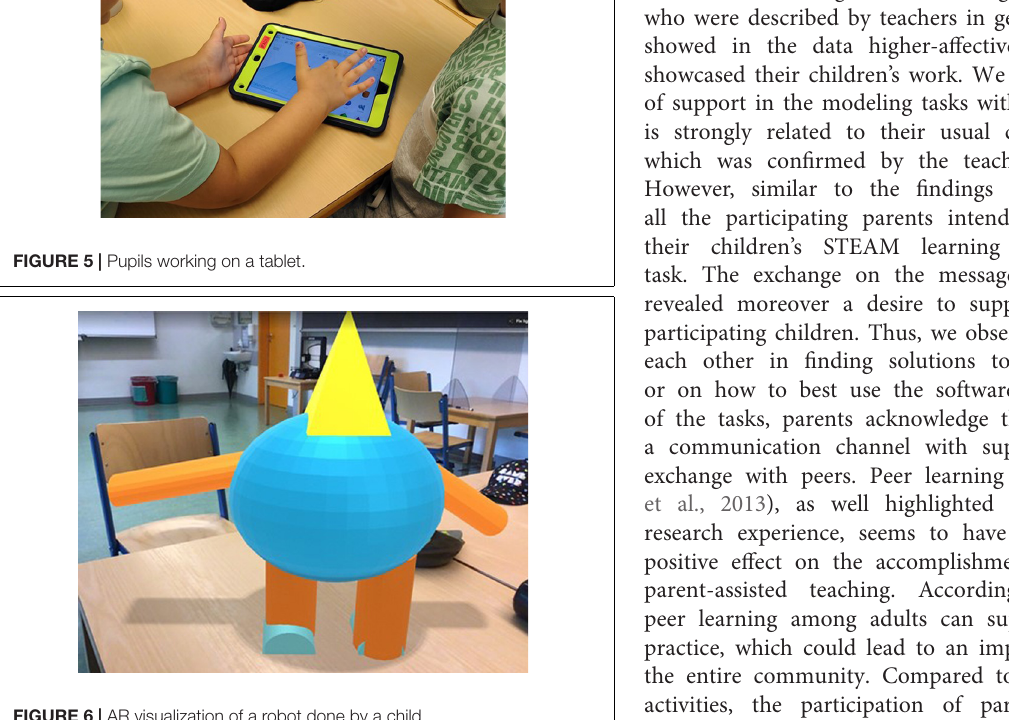
FIGURE 6 | AR visualization of a robot done by a